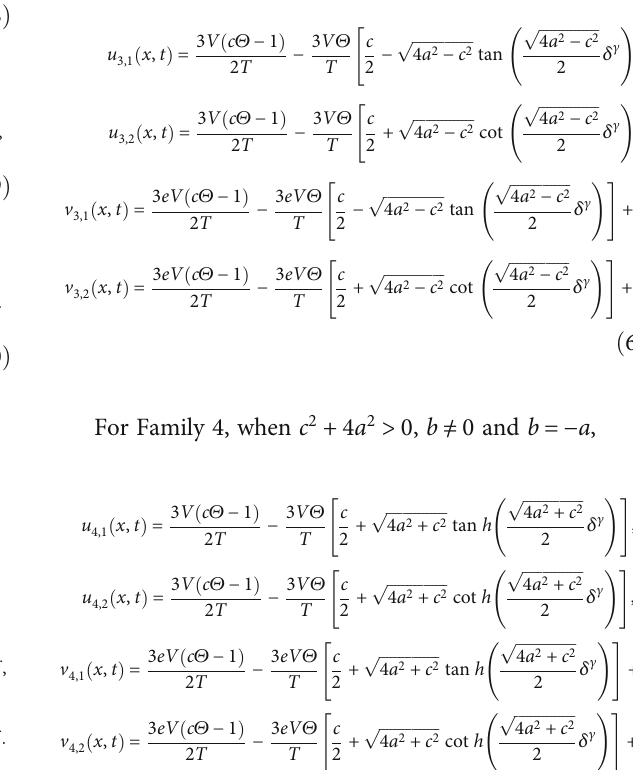
p ffiffiffiffiffiffiffiffiffiffiffiffiffiffiffiffi − c 2 − 4 ab 2